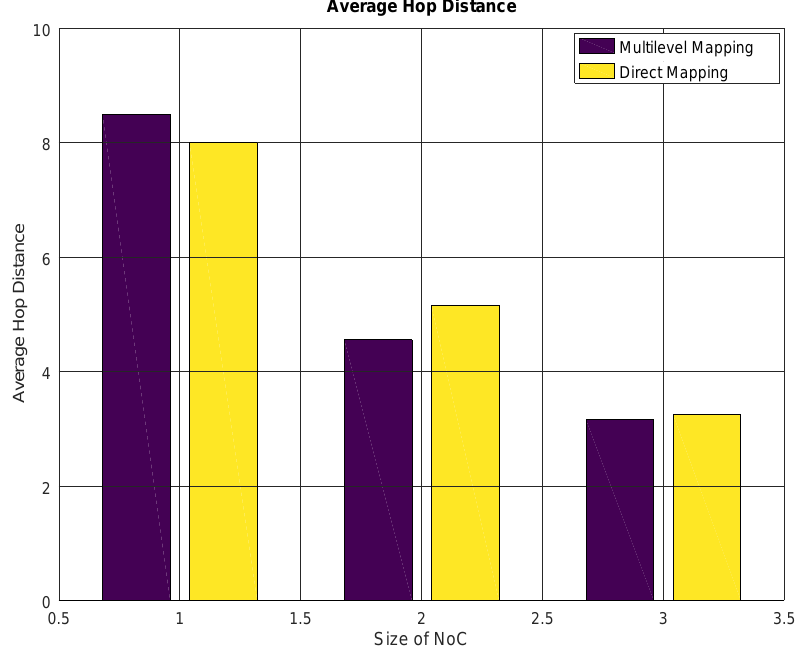
Figure 19. Average hop